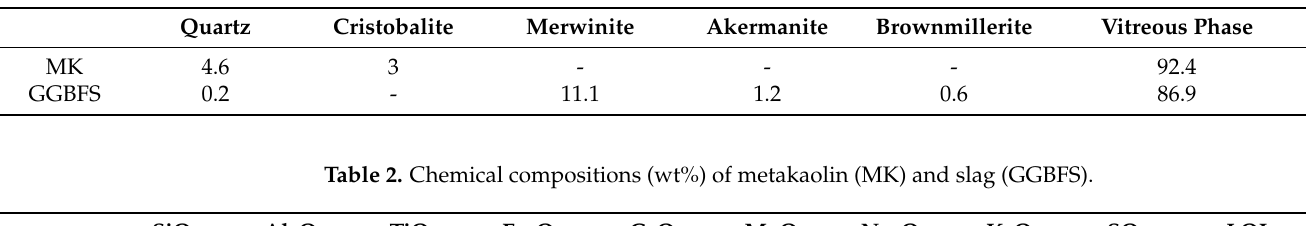
Table 1. Phase compositions of metakaolin (MK) and slag (GGBFS).